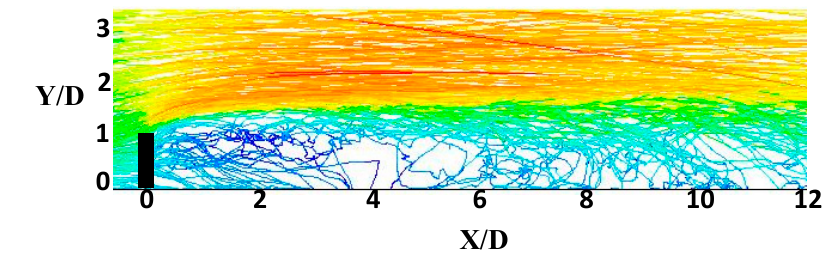
Figure 4. Contours of the sand particles.